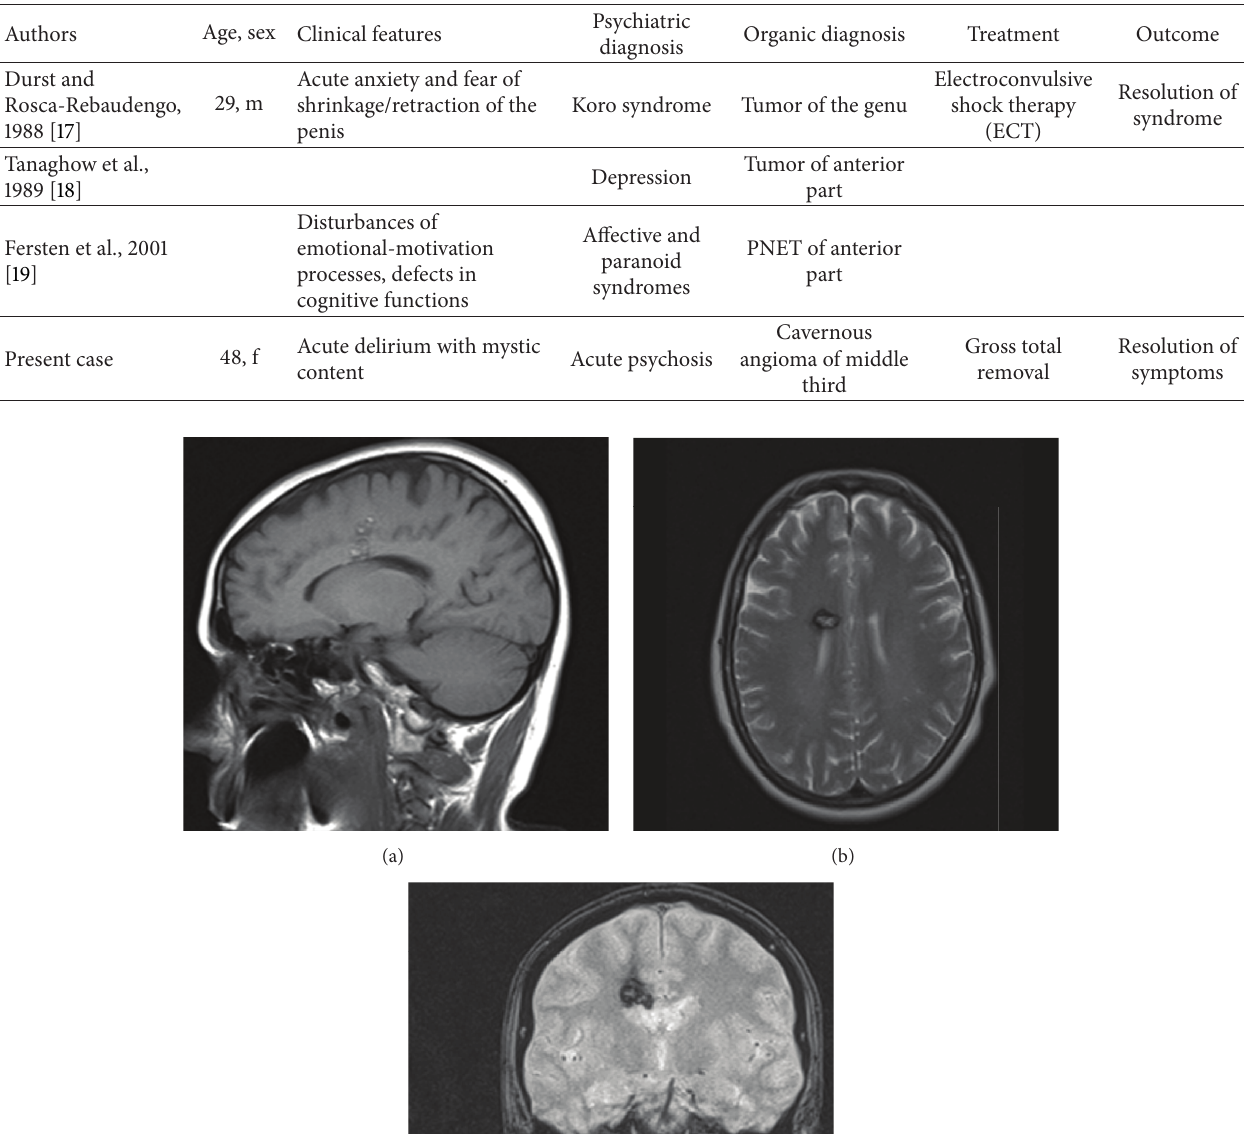
Table 1: Patients with solitary mass lesion of corpus callosum presenting with psychiatric symptoms.